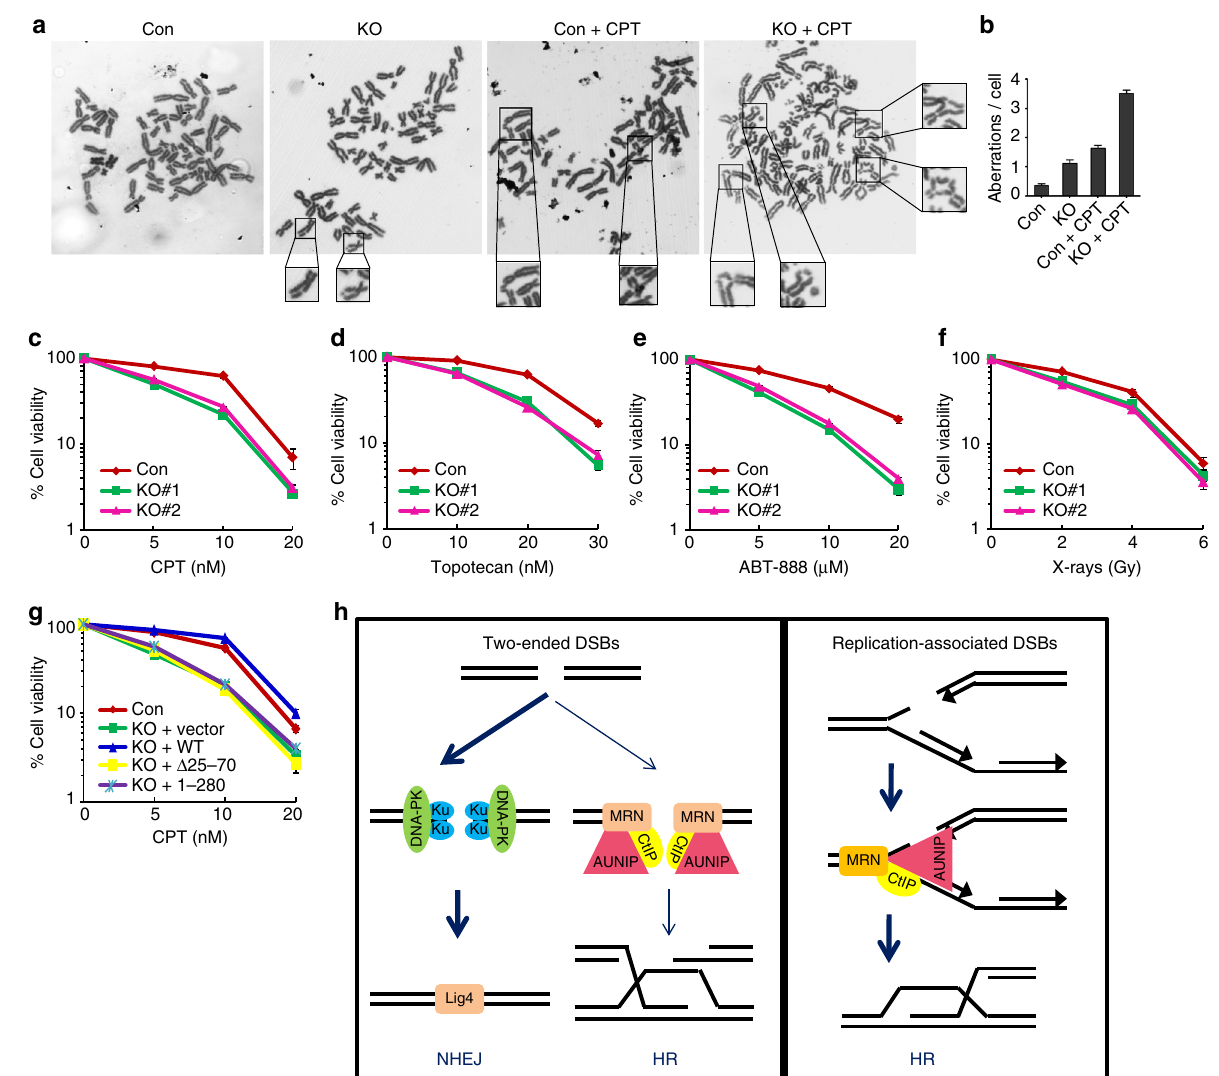
Fig. 7 AUNIP is required for genome stability and cellular resistance to DSB-inducing agents. a Wild-type or AUNIP-de fi cient HeLa cells were either mock treated or treated with 40 μ M CPT for 12 h. Metaphase spreads were then prepared following standard procedures. Representative images are shown in a . Arrows indicate chromosome aberrations. Quanti fi cation of chromosomal aberrations from indicated cells is shown in b . Data represent the average for two independent experiments. At least 50 metaphases were counted in each experiment. c – f Sensitivity of wild-type cells or AUNIP-de fi cient HeLa cells to CPT, Topotecan, ABT-888, or IR was determined by a colony formation assay. Data represent means ± SEM from three independent experiments. g CPT sensitivity of wild-type or AUNIP-de fi cient cells that stably express empty vector (Vector), wild-type AUNIP, the Δ 25 – 70 mutant, or the 1 – 280 mutant was determined by a colony formation assay. Data represent means ± SEM from three independent experiments. h Working model depicting a proposed role of AUNIP in DSB repair choice. Left panel: Noting that AUNIP displays low af fi nities for dsDNA ends, most of the two-ended DSBs are recognized and are repaired by the NHEJ machinery. Right panel: AUNIP enhances CtIP tethering at perturbed replication forks and directs replication-associated one-ended DSBs toward the HR repair repaired by NHEJ 33, 35, 36 . Importantly, re-expression of wild-type AUNIP, but not the mutants defective in DNA or CtIP binding, restored CPT resistance in AUNIP-de fi cient cells, indicating that both the CtIP-binding domain and the DNA-binding activity of AUNIP are critical for its function in promoting cellular resistance to DSB-inducing agents (Fig. 7g).